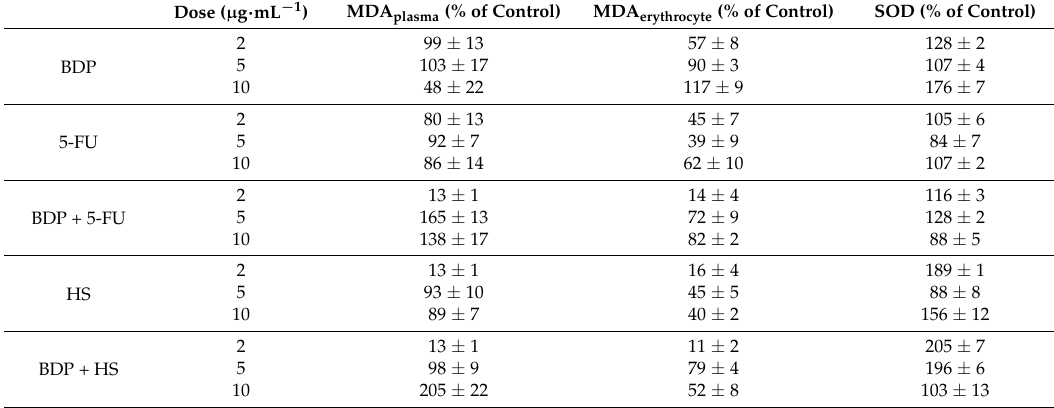
Table 5. Malonic dialdehyde level in plasma and erythrocytes, superoxide dismutase activity (% of control) under the action of 5-FU, HS, BDP, BDP + 5-FU and BDP + HS at the doses of 2, 5, and 10 µ g · mL − 1 a